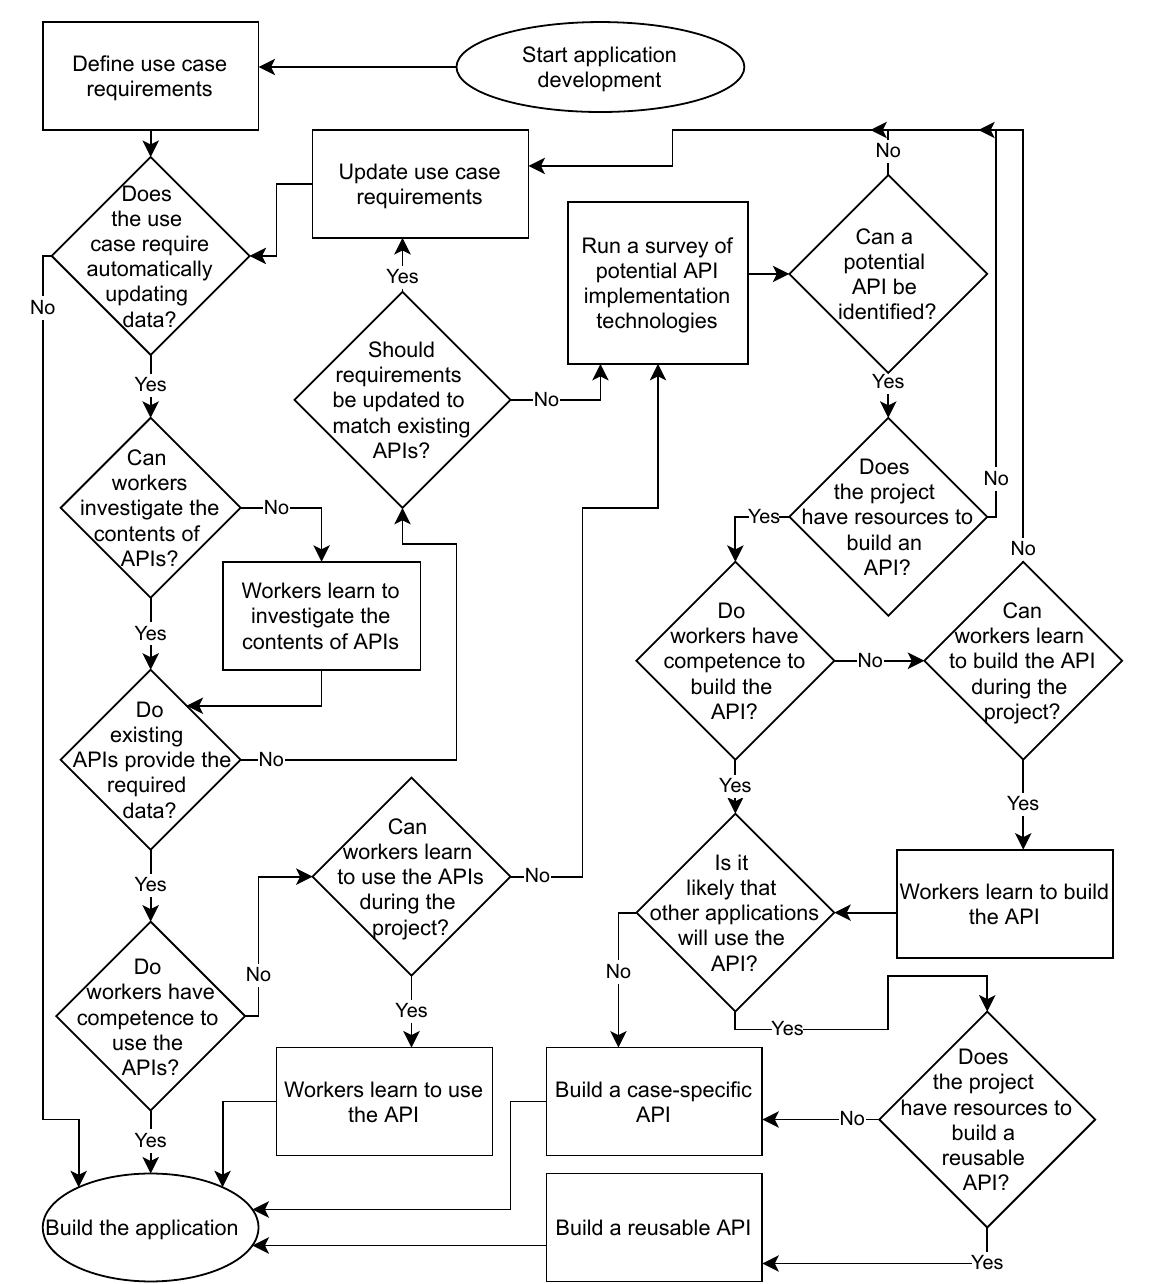
Figure 14. Flowchart for acquiring API resources for a digital twin (DT) application development project as observed